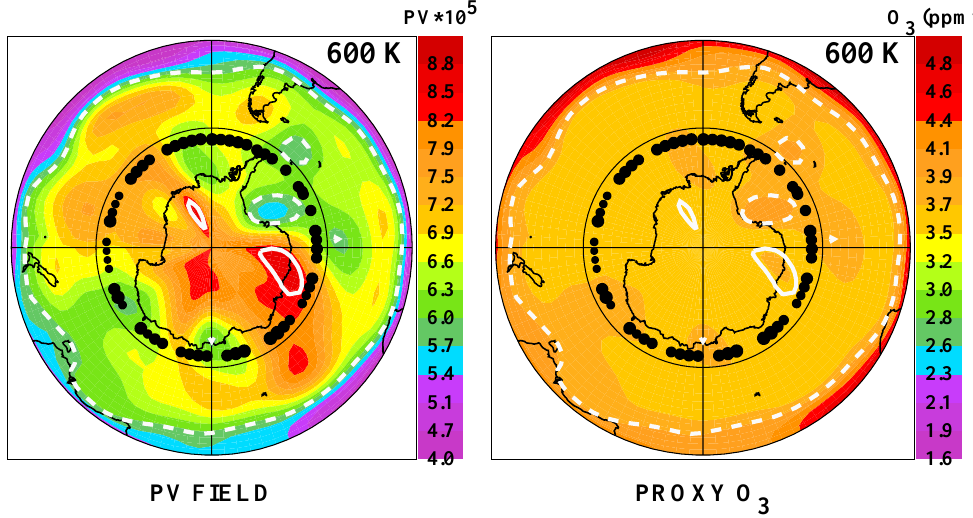
Fig. 3. Polar stereographic (30–90 ◦ S) low-resolution absolute PV (in Kkg − 1 m 2 s − 1 ) and ozone fields on the 600K isentropic surface, on 24 December 1998. Dots represent the actual POAM measurement locations. The overplotted contours border the regions where the absolute PV was higher (solid) and lower (dashed) than that sampled by POAM.